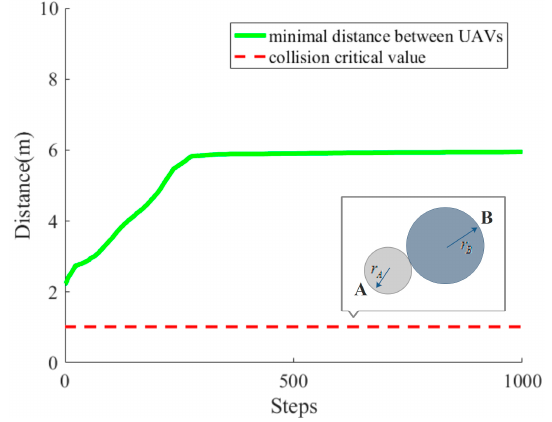
Figure 13. The variation of the minimum distance between UAVs.